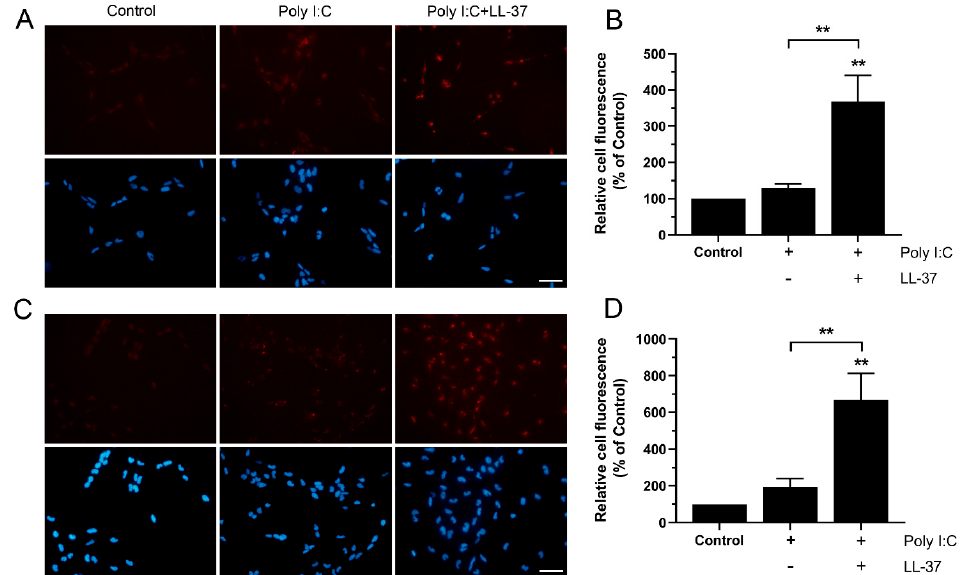
Figure 5. LL-37 triggers import of poly I:C in BEAS-2B cells. ( A – D ) Cells were treated with fluorescent rhodamine-tagged poly I:C (4 µg/mL) alone or in combination with LL-37 (4 µM) for 6 ( A , B ) and 24 h ( C , D ). The intracellular fluorescence signal (red) and the nuclei staining with DAPI (blue) were analyzed and photographed using a fluorescence microscope equipped with a digital camera. The bars in panel A and C represent 40 µm. The fluorescence intensity of five cells was measured in three different areas on each coverslip, and an average cellular fluorescence intensity was calculated for each experiment. Data are presented as mean ± SEM, n = 4 in each group representing the number of independent experiments. Statistical significance was calculated using a one-way ANOVA, followed by Tukey’s post hoc test. ** represents p < 0.01 vs. control. For comparisons indicated by the bars, ** represents p < 0.01.